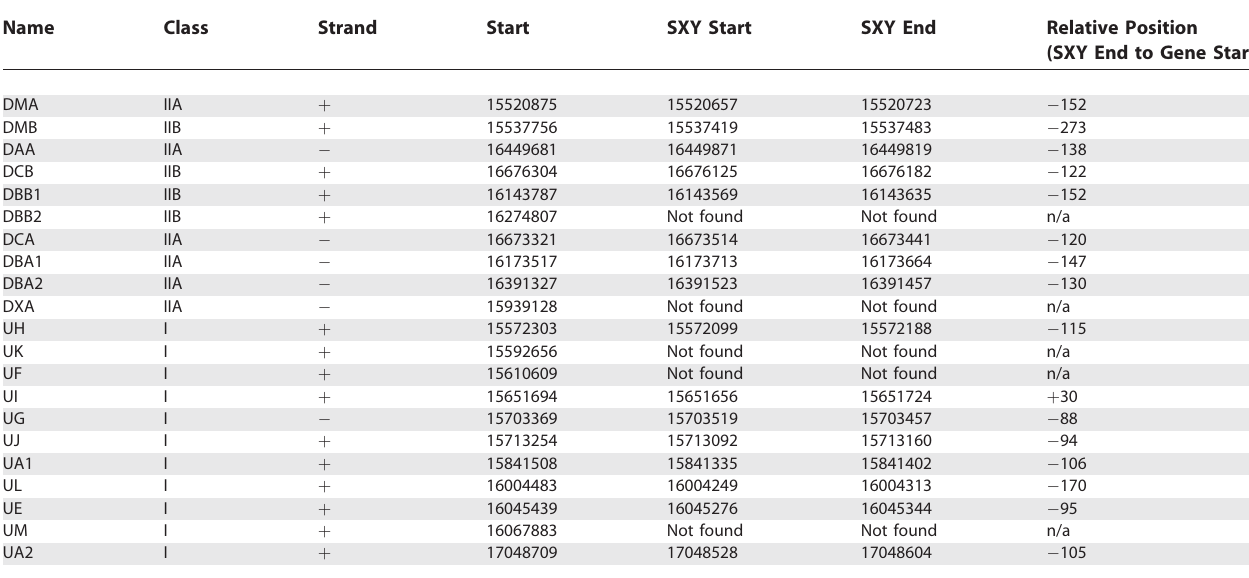
Table 1. Coordinates of the Opossum Class I and Class II Loci Located within the